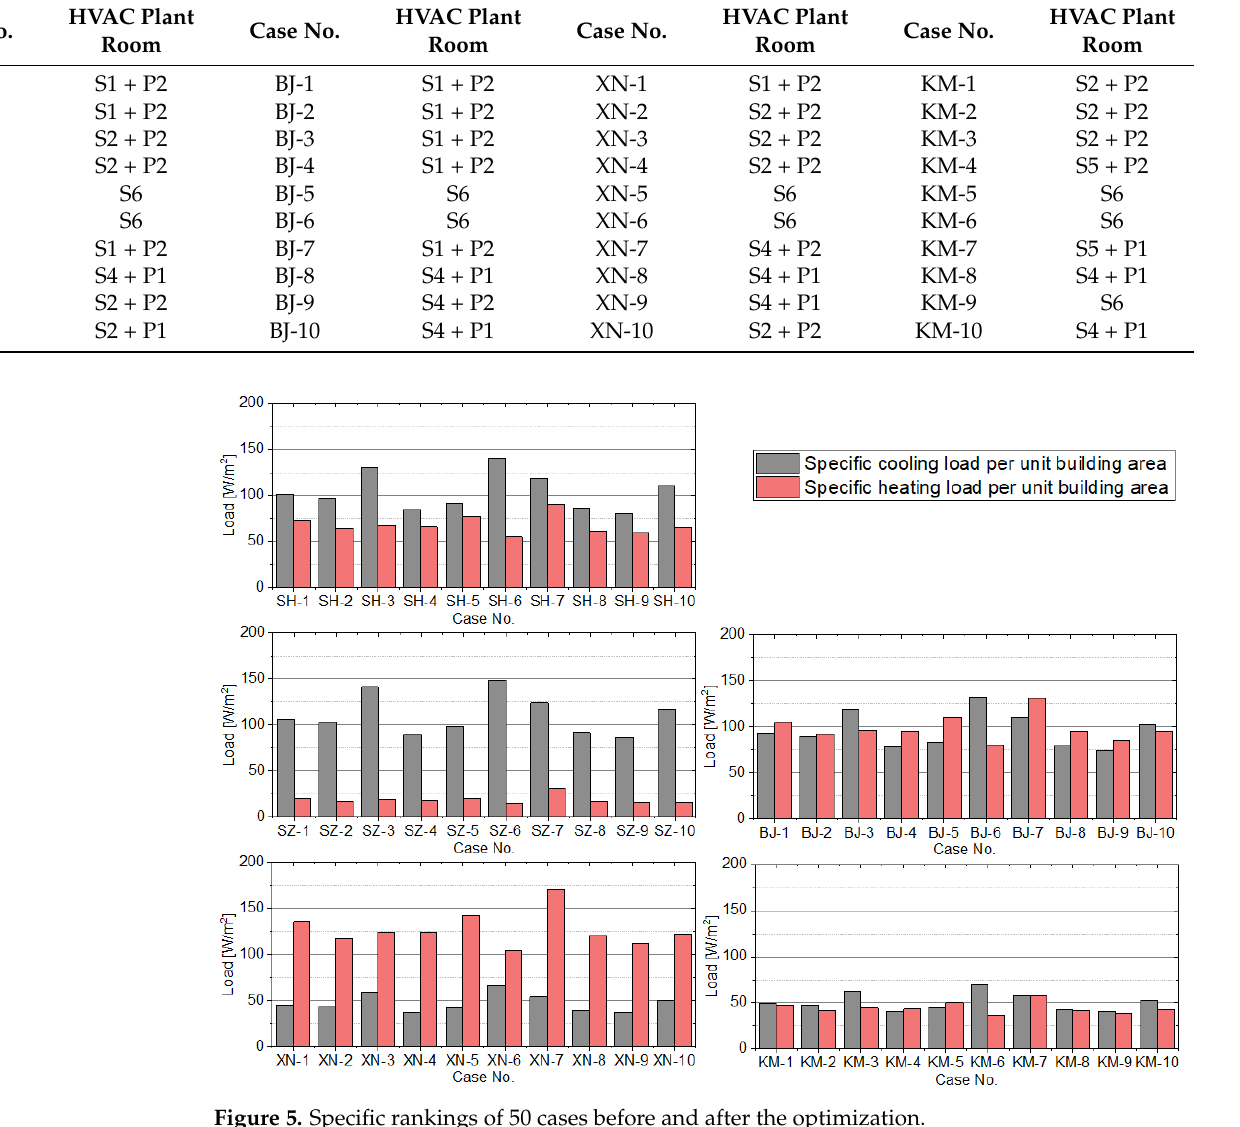
Figure 5. Specific rankings of 50 cases before and after the optimization.